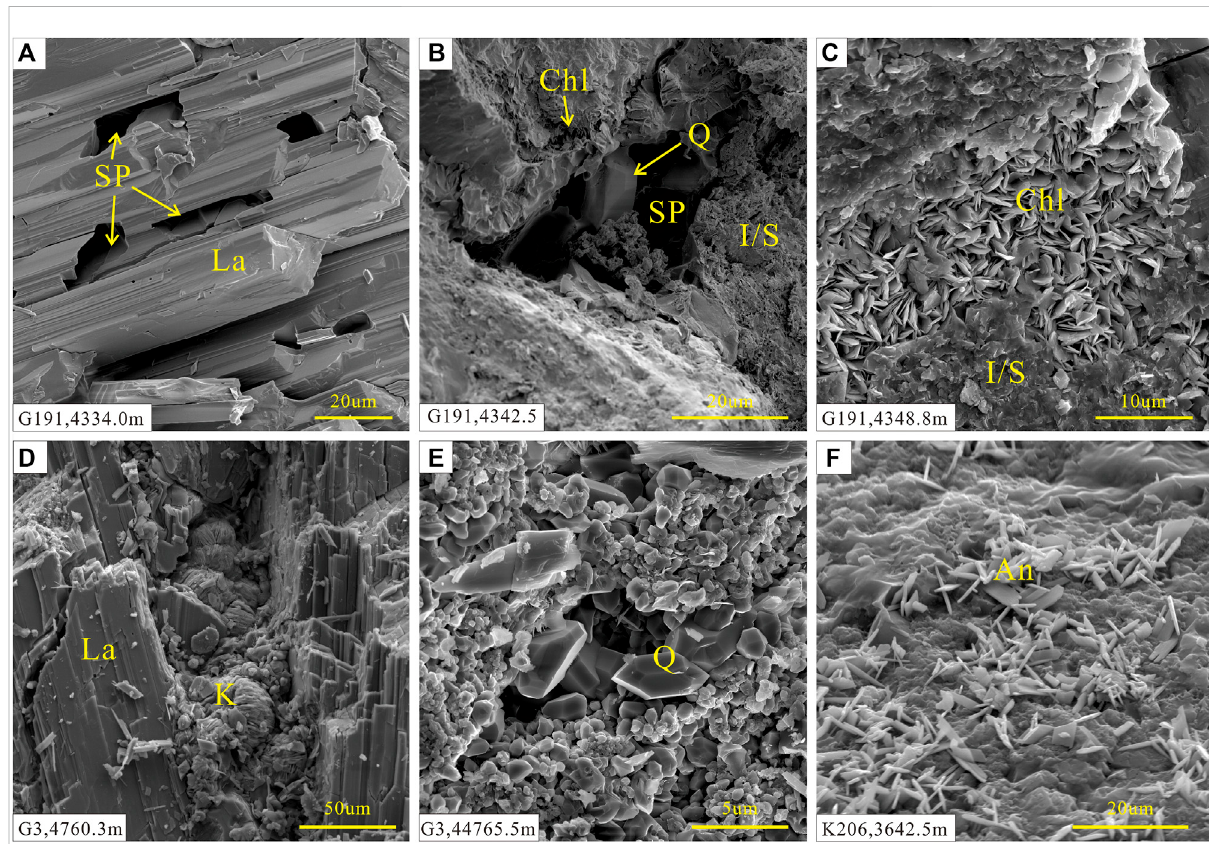
FIGURE 3 SEM images of intergranular minerals in the P 3 w sandy conglomerates. (A) Gray sandy conglomerate from the heavy oil-bearing layer. (B) Gray sandstone from the heavy oil-bearing layer. (C) Gray – green sandy conglomerate from the heavy oil-bearing layer. (D) Gray sandy conglomerate from the gas-bearing layer. (E) Gray sandy conglomerate from the gas-bearing layer. (F) Gray gravelly conglomerate from the water-bearing layer. La: laumontite, SP: secondary pores, Chl: chlorite, Q: quartz, I/S: mixed-layer illite/smectite, (K) kaolinite, An: